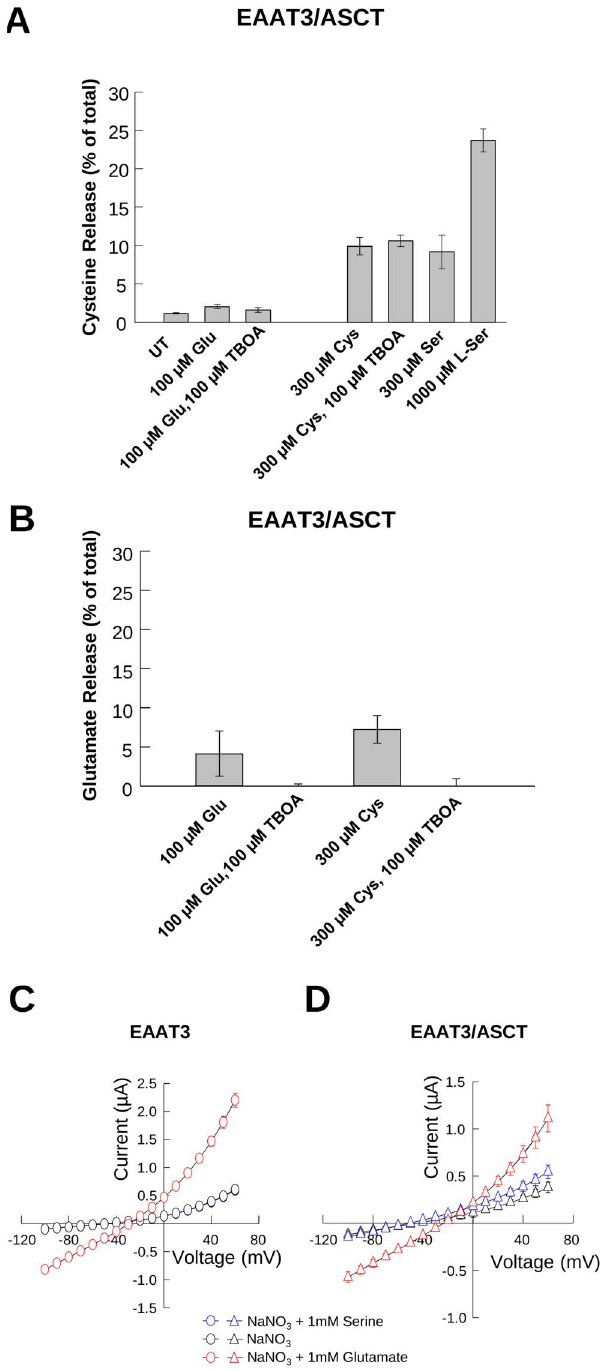
Figure 7. EAAT3 dependent release of [ 3 H]-L-glutamate or [ 35 S]-L-cysteine. A and B) Release of [ 35 S]-L-Cysteine ( A ) or [ 3 H]-L- Glutamate ( B ) from oocytes co-expressing EAAT3 and ASCT, in response to different buffers and conditions C) Averaged current-voltage relationships recorded from oocytes expressing EAAT3 alone (n=6) or co-expressed with ASCT1 (n=4) in response to a family of voltage pulses in the absence (black symbols) and the presence of 1 mM serine (blue symbols) or 1 mM glutamate (red symbols). The solid line represents un-injected oocytes in the presence of 1 mM glutamate and 1 mM serine (n=3).